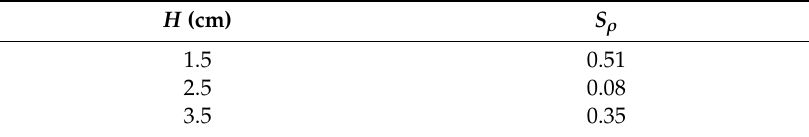
Figure 5. Effect of height of the partition plate on the average density of particles in the bed. ( a ) H = 1.5 cm; ( b ) H = 2.5 cm; ( c ) H = 3.5 cm. Table 4. S ρ for different values of H .